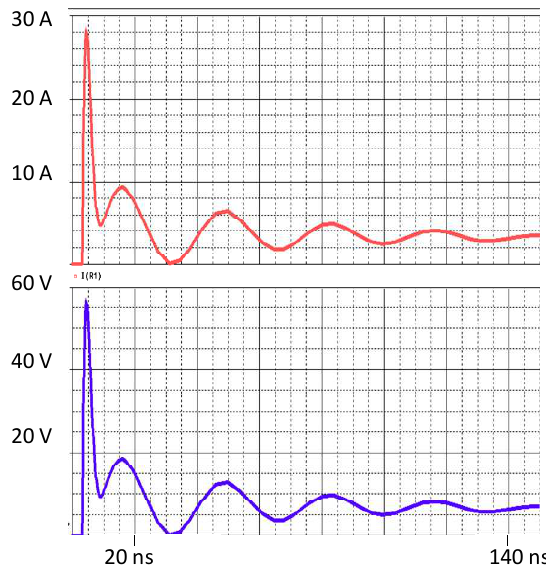
Figure 2: Simulation of induced current and voltage on a 2 Ohms load by 8 kV ESD pulse (2 kOhms / 330 pF).